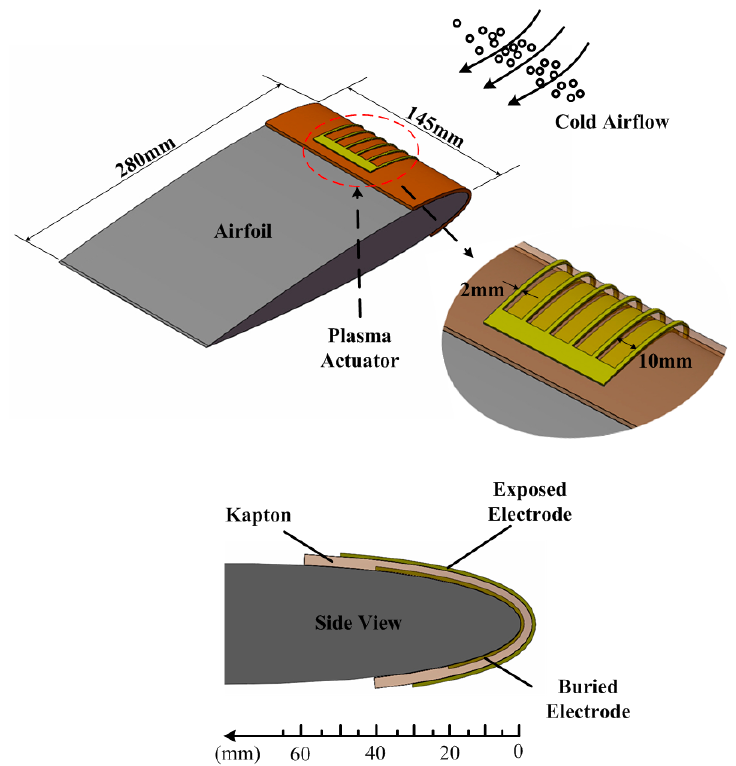
Figure 3. A NACA 0012 airfoil model.